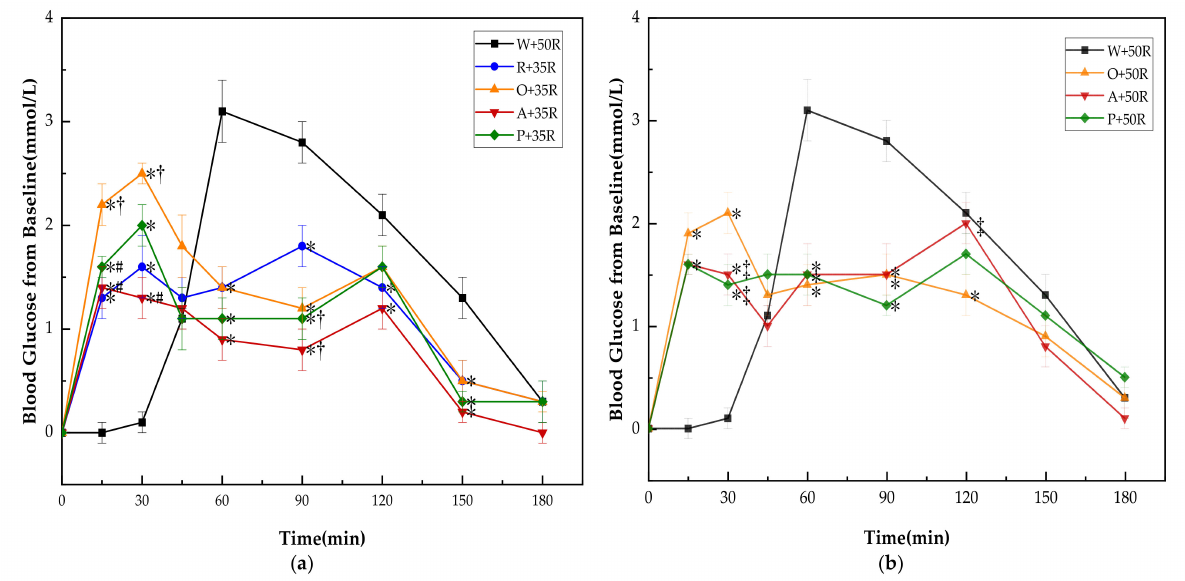
Figure 3. ( a ) PGRs for reference and IC test meals; ( b ) PGRs for reference and HC test meals. G, glucose; R, rice; O, oranges; A, apples; P, pears; W, water. Data are presented as the mean values with their standard errors, n = 14. * Test meals different from W + 50R, † Test meals different from R + 35R, # Test meals different from O + 35R, ‡ Test meals different from O + 50R ( p < 0.05).